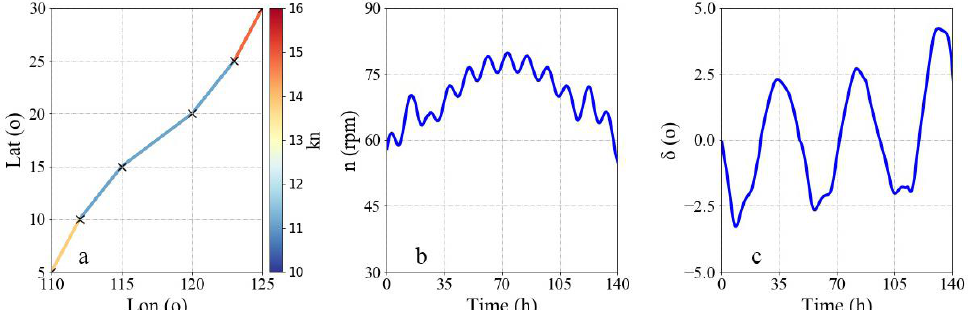
Figure 6. Optimization result under the effects of the wind, waves and currents. ( a ) Speed distribution, ( b ) rotating speed of propeller command, and ( c ) rudder angle command.